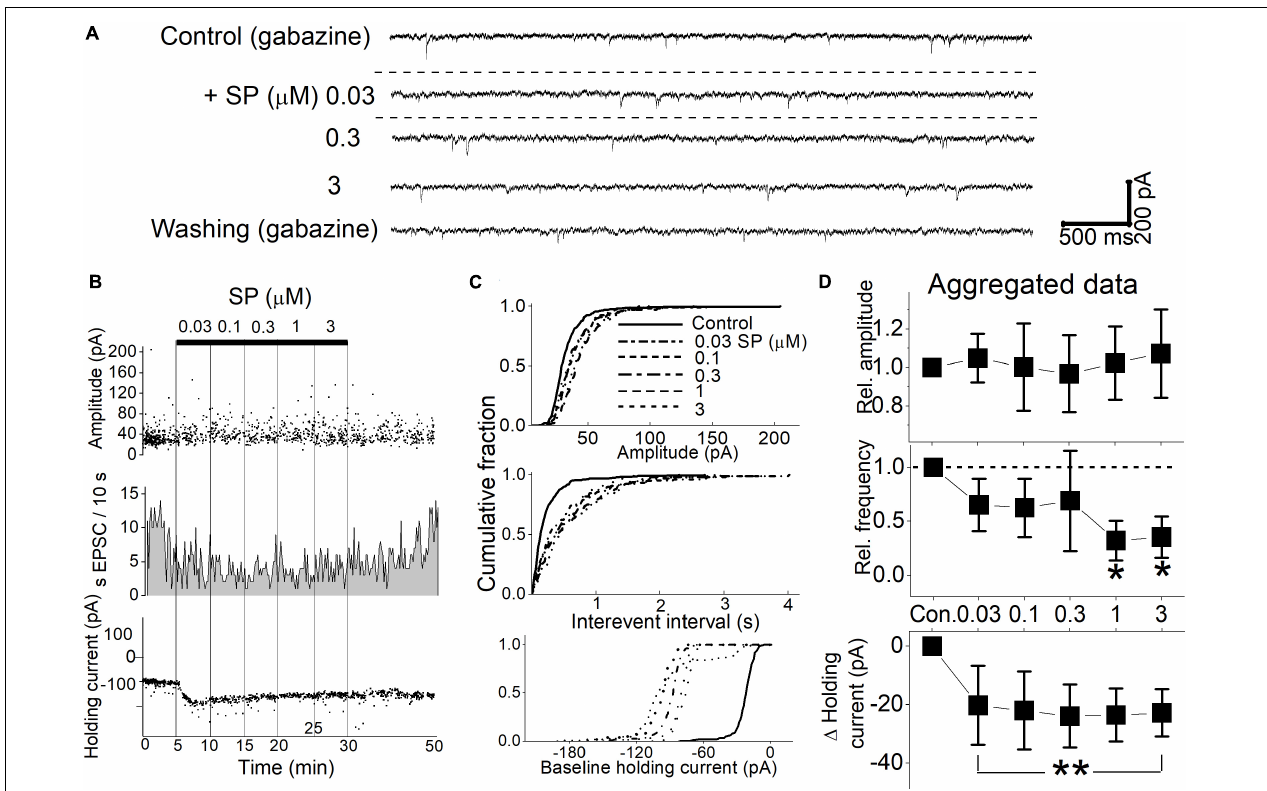
FIGURE 3 | SP effect on sEPSCs and holding currents. (A) Glutamatergic sEPSCs were isolated with gabazine (6 µ M) and recorded at a holding potential of -50 mV. SP (0.03–3 µ M) was applied in a cumulative manner. The slices were washed with ACSF for 1 min before higher concentrations of SP were applied. The dashed line indicates the mean holding current before SP treatment. (B) Diary plots display the event characteristics of the sEPSCs of representative neurons (upper traces) during the cumulative application of 0.03–3 µ M SP. The amplitude (top panel), frequency value (second panel), and holding current (bottom panel) values for each detected sEPSC are displayed. (C) Corresponding cumulative fractions of event measurements shown for each of the individual sEPSCs shown in (B) . Each panel shows the effect of SP on the sEPSC amplitude (top panel), interevent interval (middle panel) and holding current (bottom panel). The baseline holding currents were measured as the absolute current (pA) of the individual responses. (D) Summary aggregate data for sEPSCs. Measurements were normalized by the control amplitude and frequency of the neurons before compiling the averages. Changes in the baseline holding currents were calculated as changes from the control condition in absolute